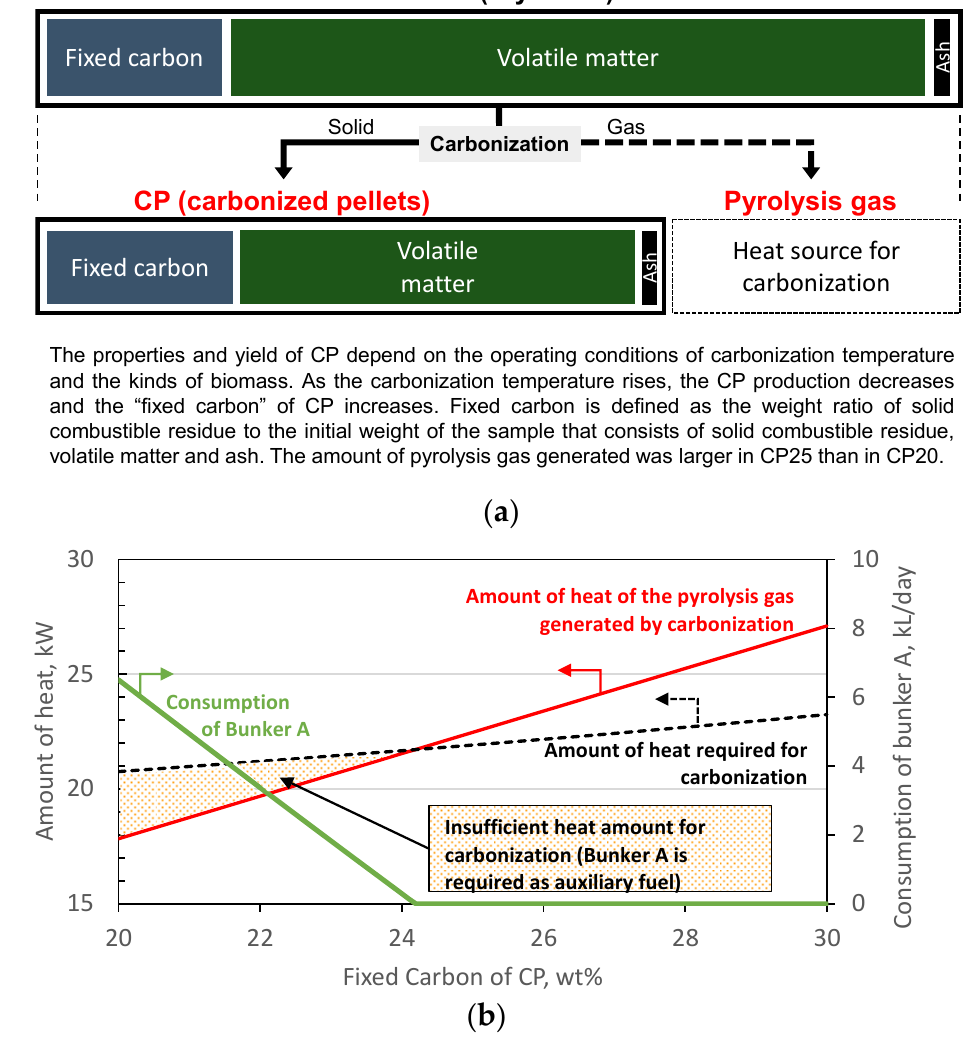
Figure 2. Conceptual diagram for CP and the pyrolysis gas generated by carbonization, and the auxiliary fuel consumption obtained from a heat/mass balance analysis of the carbonizer: ( a ) conceptual diagram of changes in components based on proximate analysis before and after carbonization; ( b ) relationship between the amount of heat of the pyrolysis gas generated by the carbonizer, the amount of heat required for the carbonizer, the amount of consumption of bunker A as auxiliary fuel, and the fixed carbon of CP.